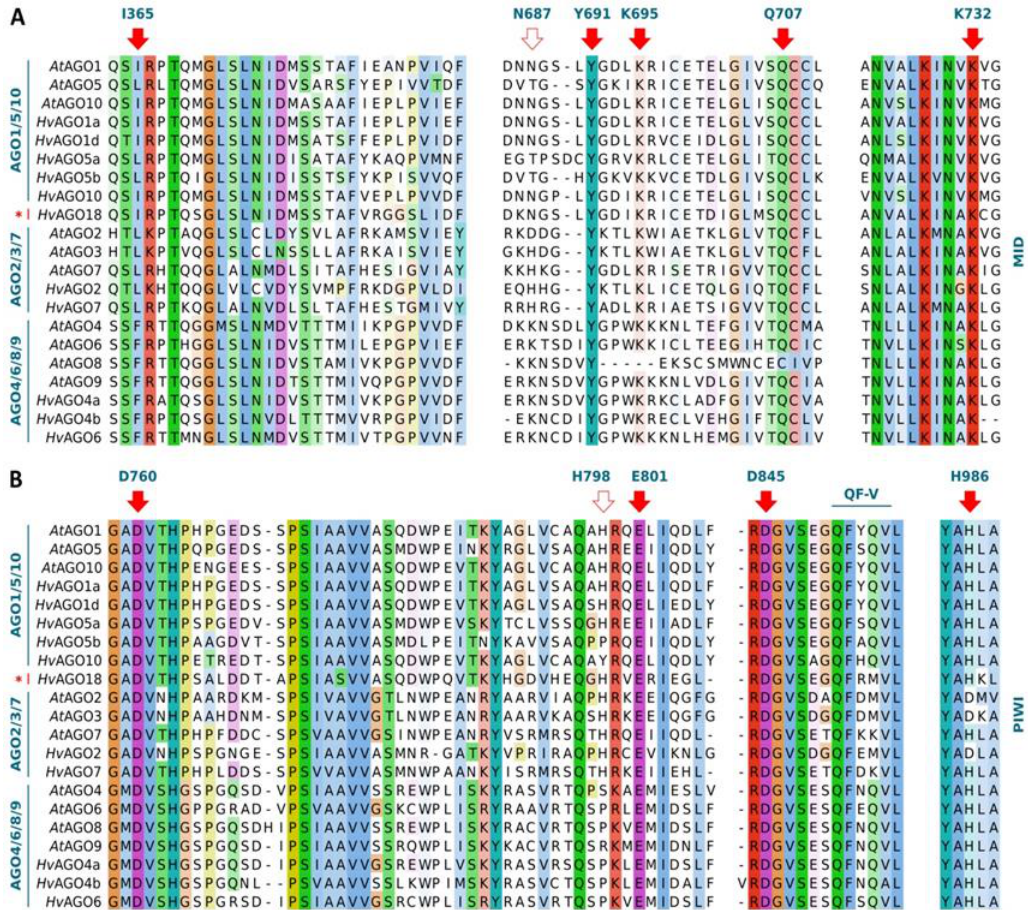
Figure 6. Functionally conserved positions within MID and PIWI domains of A. thaliana and barley AGO proteins. Residues within ( A ) MID domain sRNA-target interaction (I365, red arrow), 5′ terminal nucleotide selection (N687, open arrow) and 5′-phosphate-binding (YKQK, red arrows) residues and ( B ) PIWI domain catalytic tetrad ((DED[D/H], red arrows), additional H residue (open arrow) and QF-V motif (blue line)) are indicated. Residue numbers correspond to AtAGO1 amino acid positions. AGO clades are shown on the left. Monocot-specific AGO18 clade is marked with a red star. For full-length alignment of AGOs see Figure S2.